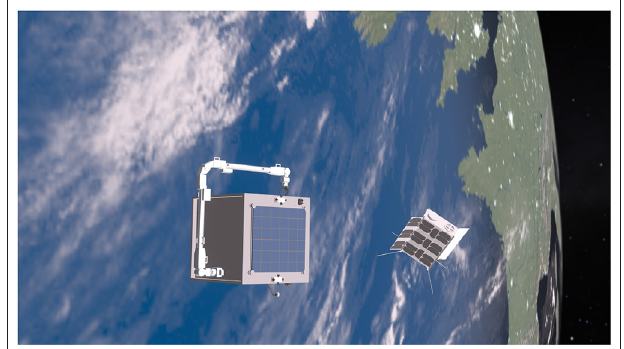
FIGURE 2 | The conceptual mission for capturing and servicing a non-cooperative but known 16U CubeSat.